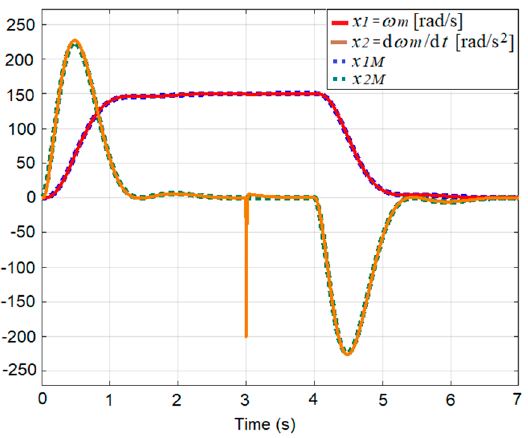
Figure 6. The effect of change of rotor resistance R 2 = 2 R 2 N on control dynamics at motor starting and loading.